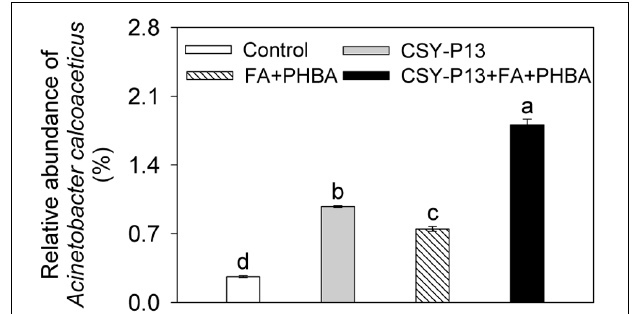
FIGURE 9 | Effects of CSY-P13 and the mixture of FA and PHBA on relative abundance of one OTU, which is identified as Acinetobacter calcoaceticus by using sequence alignment of 16S rRNA gene sequences. Bars represent standard errors of three biological replicates. Values with the different letters are significantly different at P < 0.05 by LSD test using SPSS for Windows 22.0 software (IBM Corp., Armonk, NY, United